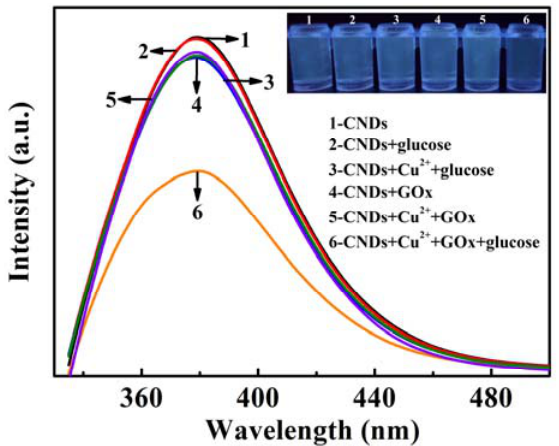
Figure 5. Fluorescence spectra of free CNDs ( 1 ) and CNDs in the presence of glucose ( 2 ), Cu 2+ and glucose ( 3 ), GOx ( 4 ), Cu 2+ and GOx ( 5 ), and the mixture of Cu 2+ , glucose and GOx ( 6 ). The final concentrations of CNDs, glucose, Cu 2+ and GOx were 0.014 mg/mL, 5 mM, 600 nM and 10 U/mL respectively. The inset shows the corresponding images under UV light at 365 nm.